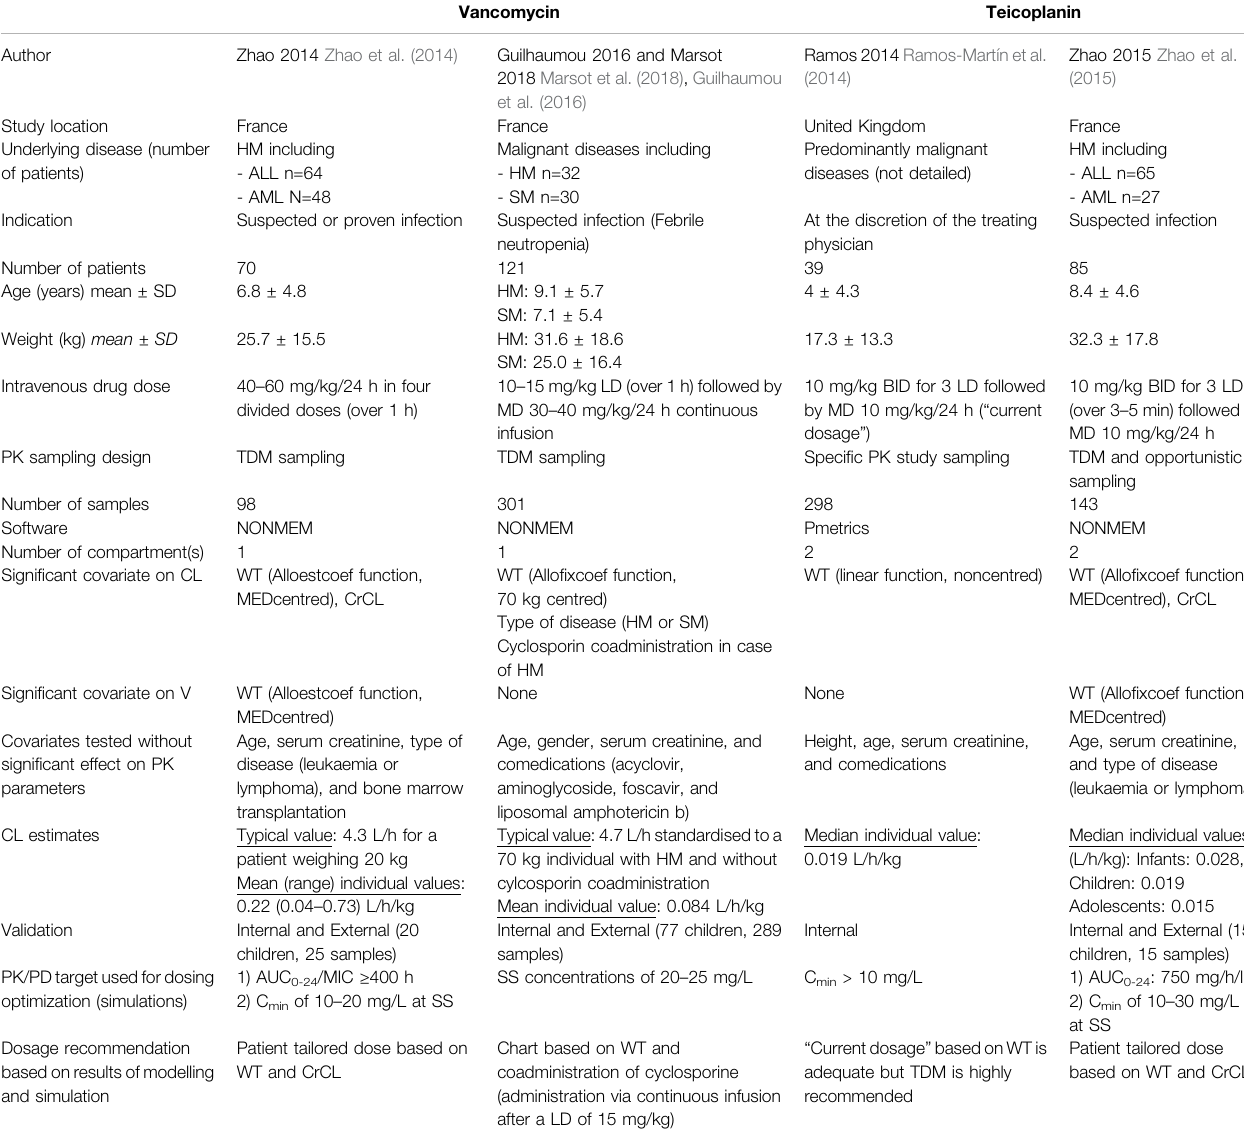
TABLE 2 | Population pharmacokinetic studies of glycopeptides in paediatric onco-hematological